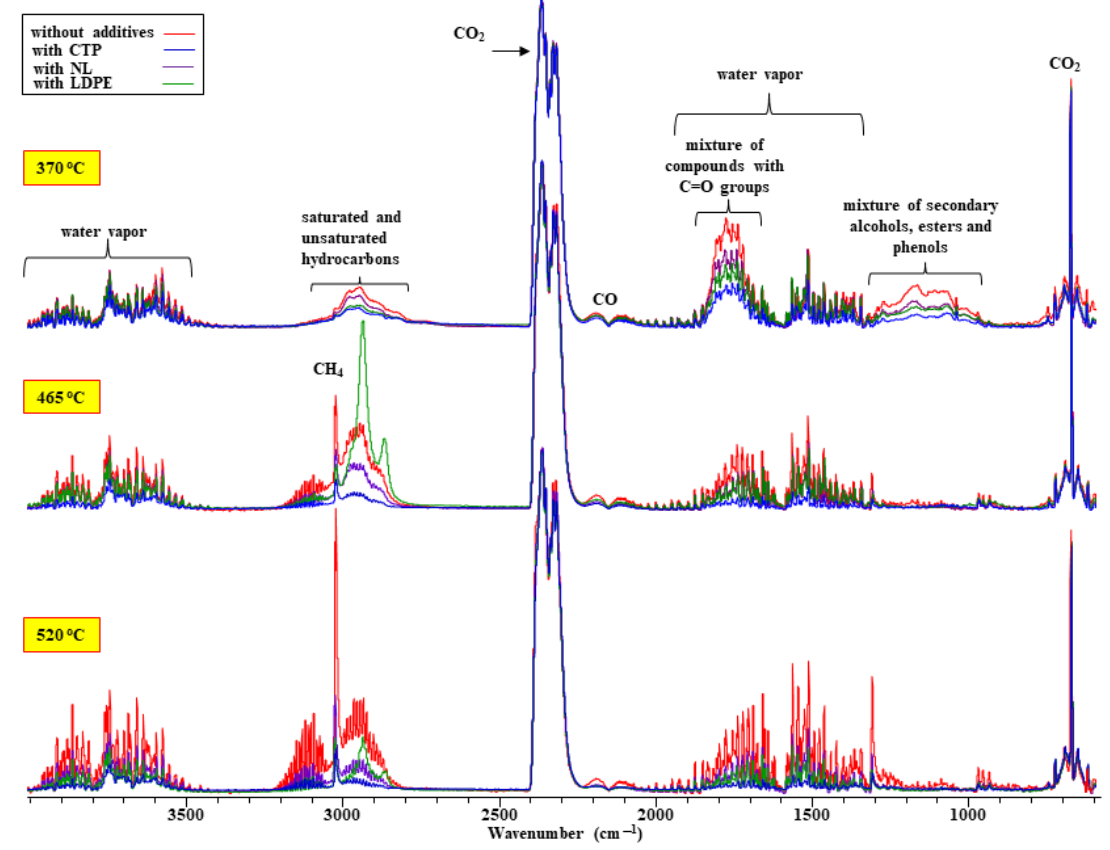
Figure 7. The FT–IR spectra of volatile products of pyrolysis.